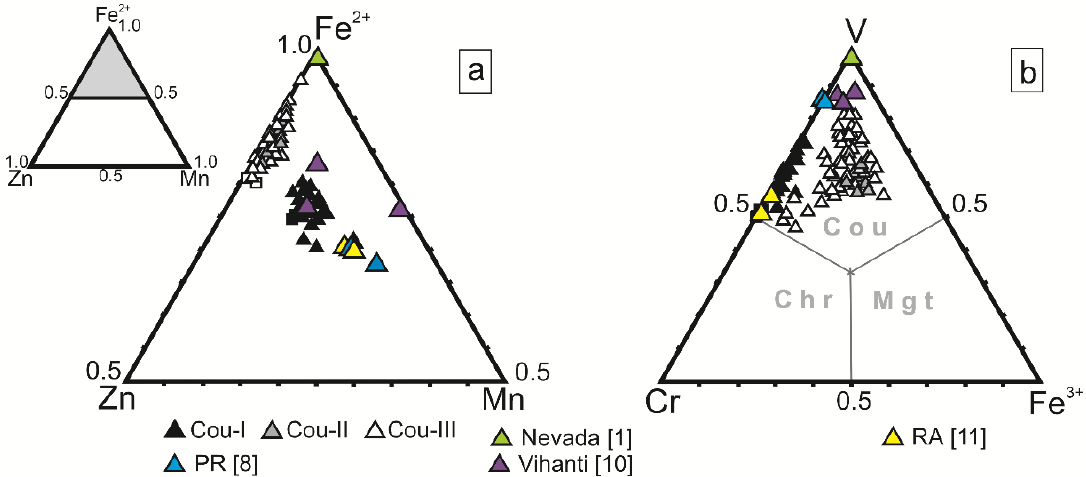
Figure 3. Triangle diagrams of cation distribution in coulsonite from different massive sulfide deposits: ( a )—in position A ; ( b )—in position B (according to the main structural formula AB 2 O 4 of the spinel group minerals).